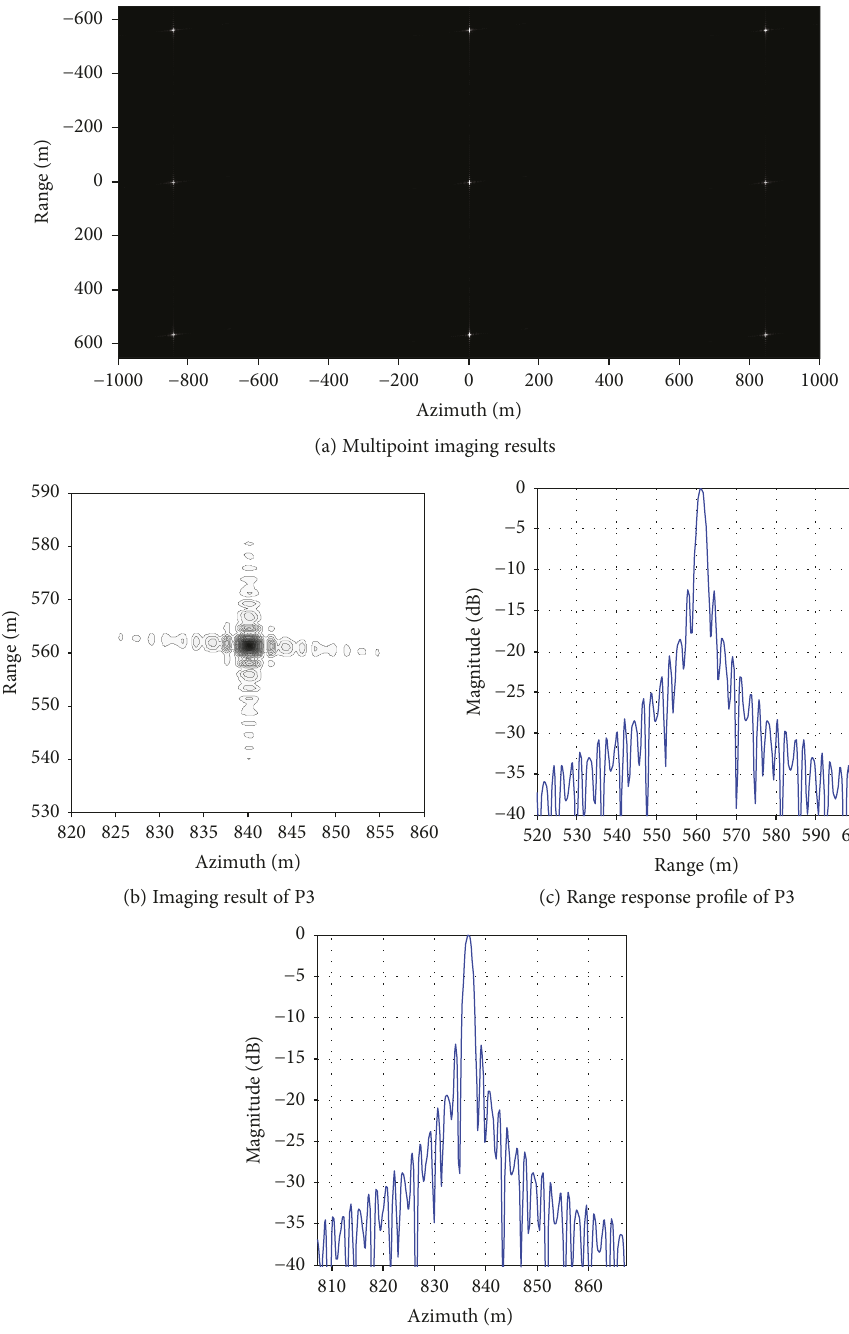
Figure 7: Imaging results in the sliding spotlight mode of the